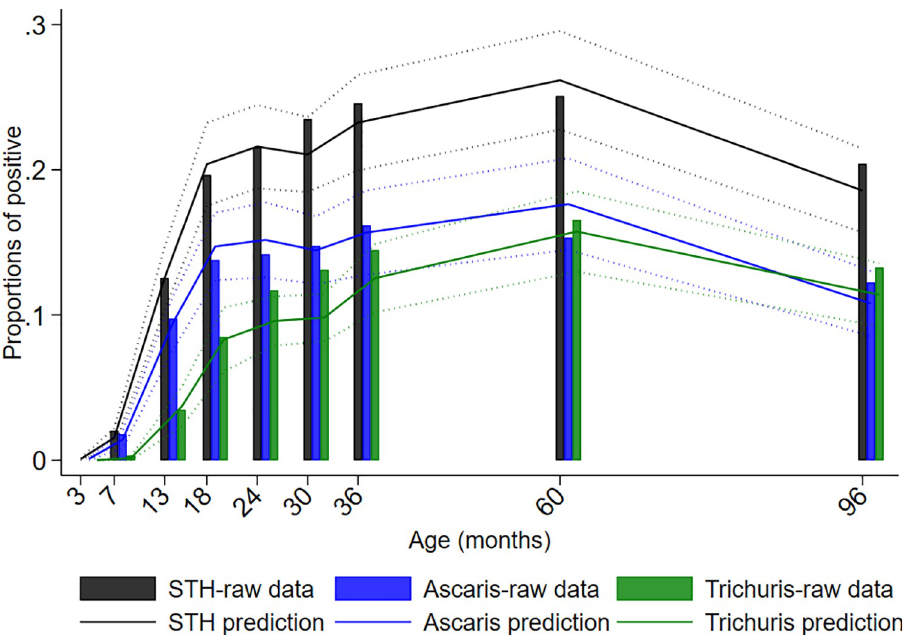
Fig 5. Observed proportions and predicted age-dependent prevalence of infection with any soil-transmitted helminth (STH). A . lumbricoides (Ascaris), and T . trichiura (Trichuris) in the cohort during the first 8 years of life. Age is shown in